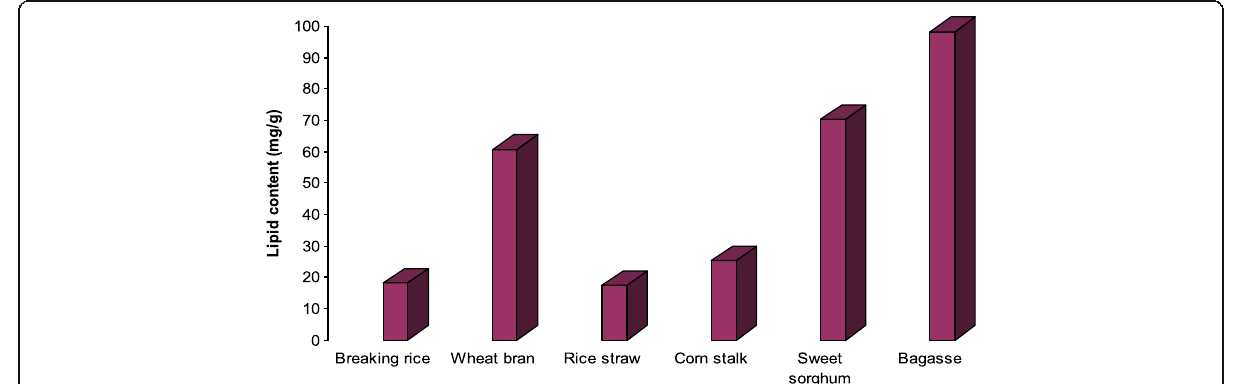
Fig. 10 Lipid production by F. oxysporum NRC 2017 using different by products as semi solid